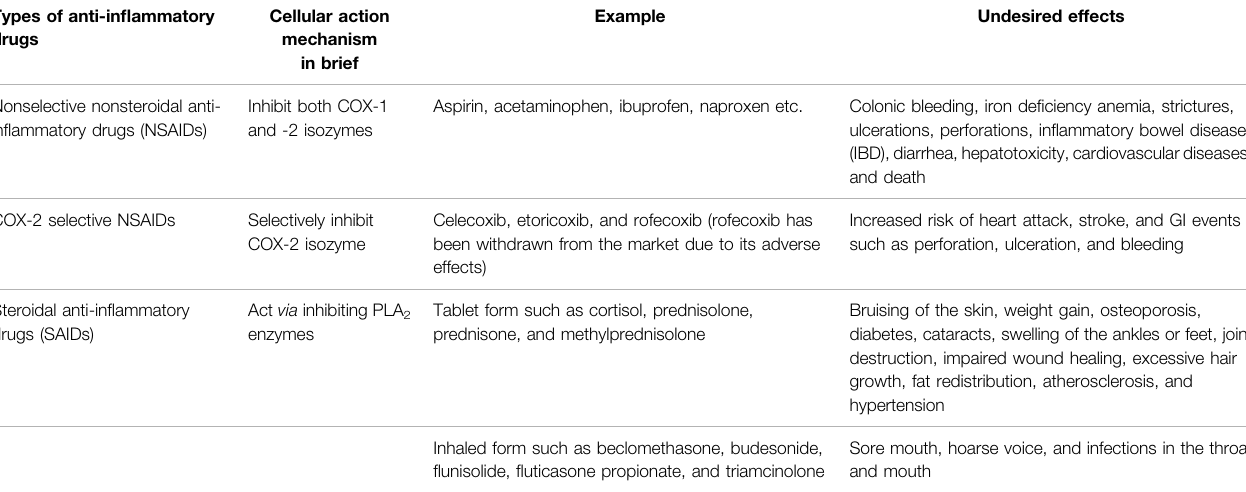
TABLE 1 | Cellular action mechanism of anti-in fl ammatory medications and their undesired